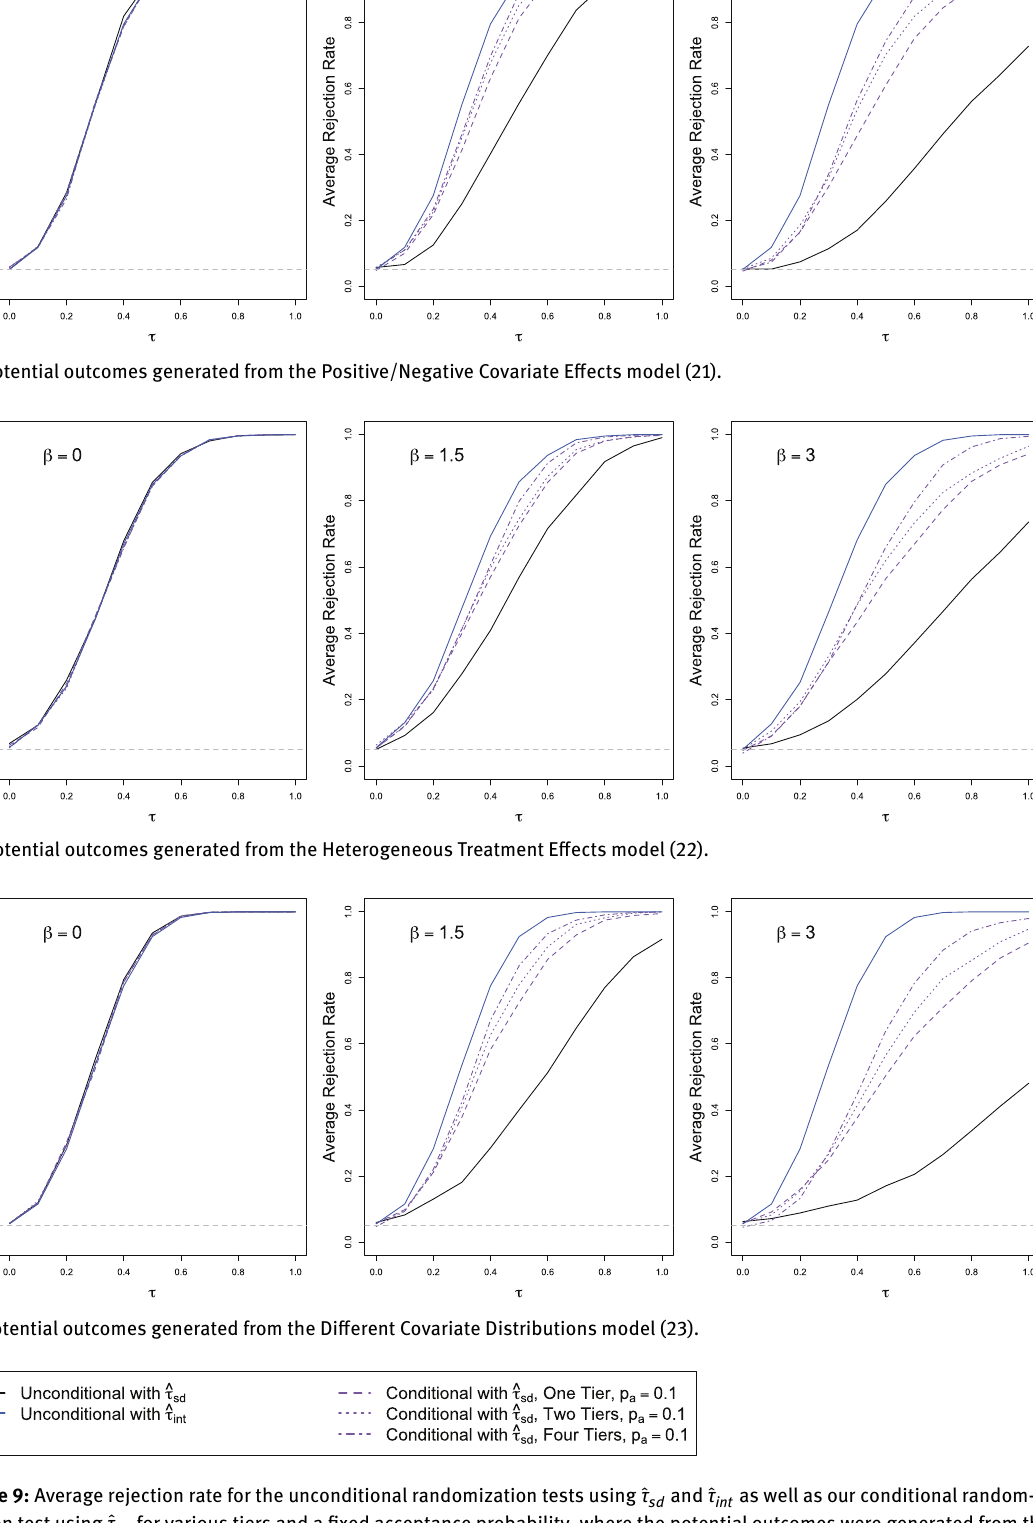
Figure 9: Average rejection rate for the unconditional randomization tests using ̂ τ sd and ̂ τ int as well as our conditional random- ization test using ̂ τ sd for various tiers and a fixed acceptance probability, where the potential outcomes were generated from the Positive/Negative Covariate Effects model (21), Heterogeneous Treatment Effects model (22), or Different Covariate Distributions model